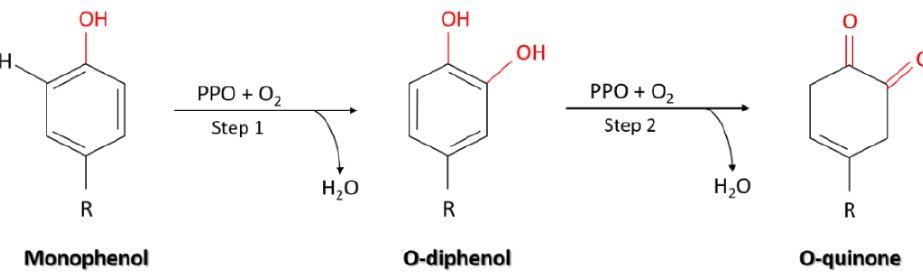
Figure 1. Schematic illustration of the reaction mechanism catalyzed by polyphenol oxidase (PPO).